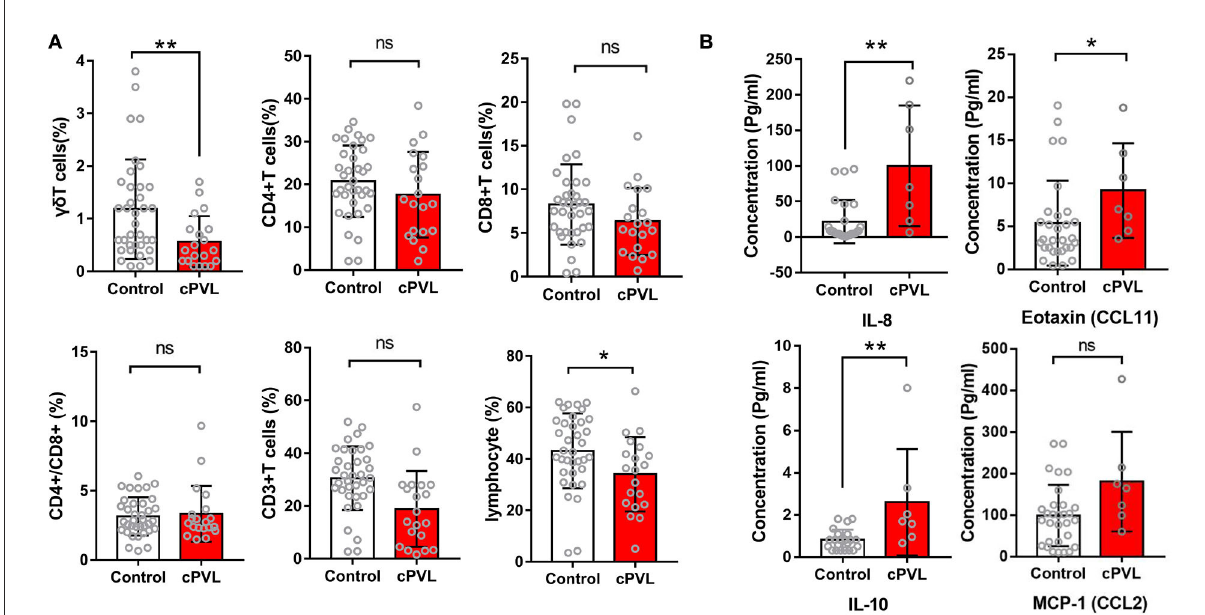
FIGURE3 Distribution of peripheral blood T-cell subsets is within the lymphocyte population and serum cytokine concentrations in two groups of preterm infants. (A) Dot bar graphs showing the percentage of γδ T, CD3 + T, CD4 + T, CD8 + T, CD4 + T/CD8 + T, and lymphocytes cells in cPVL ( n = 20) and control (n = 36) groups. (B) Dot bar graphs showing the percentage of serum concentration of IL-8, IL-10, eotaxin (CCL11), and MCP-1 (CCL2) in cPVL ( n = 7) and control ( n = 30) groups. A Mann–Whitney U- test was performed for all analyses, and a P < 0.05 was considered significant. *** P ≤ 0.001; **0.001 < P ≤ 0.01; *0.01 < P ≤ 0.05; ns: P >0.05.